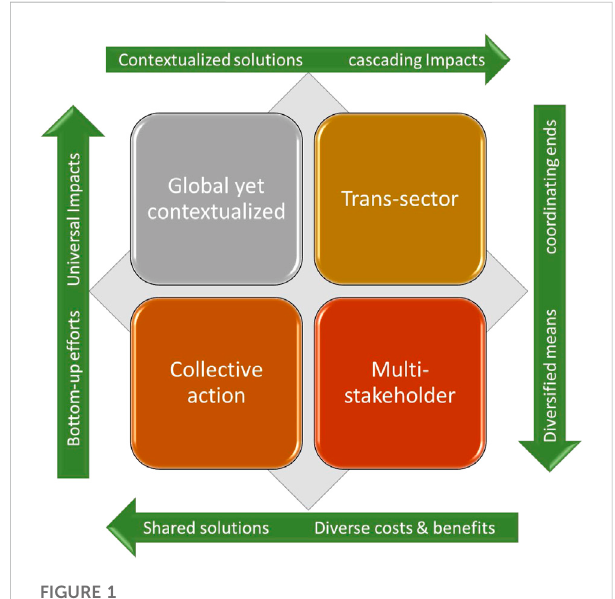
Climate Change is a complex multi-dimensional problem. Institutional transformation must happen across all these dimensions to enable climate